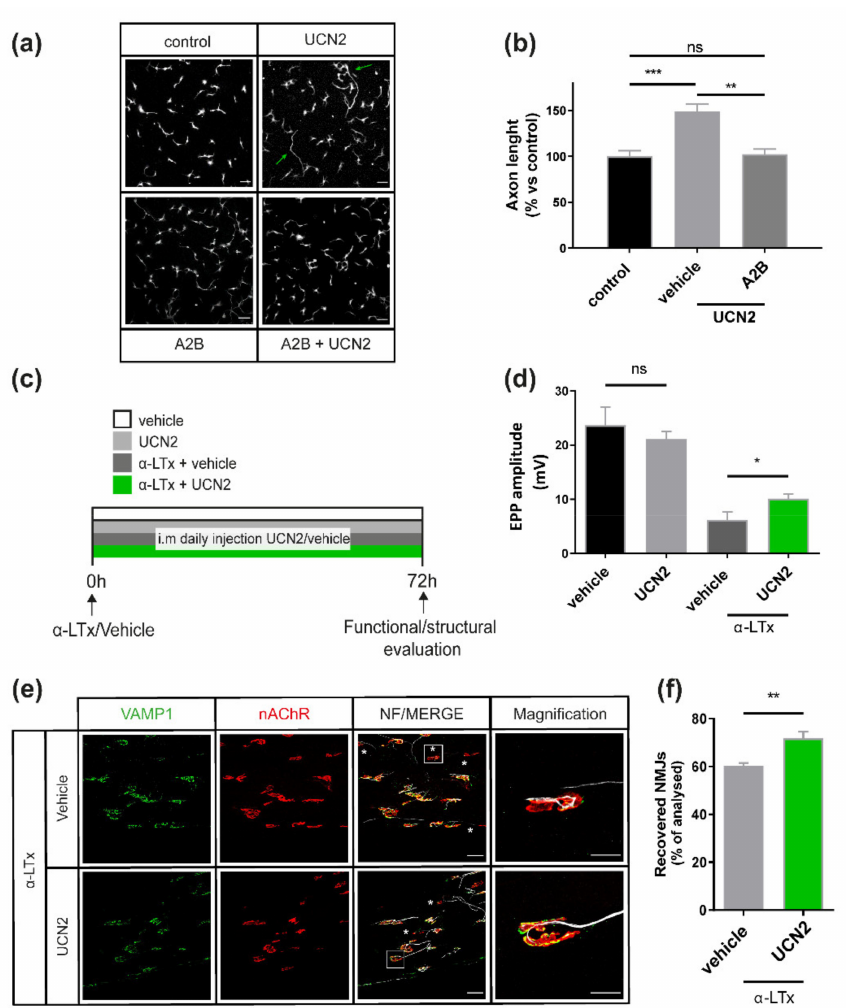
Figure 4. The UCN2-CRHR2 axis promotes axonal growth of cultured SCMNs and NMJ regeneration after acute damage. ( a ) Representative images of neurofilament staining used as reporter for axon length in SCMNs cultured for 24 h either in normal culture medium (NC) or NC supplemented with UCN2, A2B or their combination. ( b ) Quantification of the average axonal length after the indicated treatments. Three independent experiments were performed, and at least 100 neurons per condition measured. Bars represent mean ± SD. Statical analysis was performed with ANOVA followed by post hoc Tukey test; *** p < 0.001, ** p < 0.01, ns p > 0.05. ( c ) Scheme illustrating the treatment protocol, consisting of daily i.m. injections of either vehicle or recombinant UCN2 for 72 h after α -LTx treatment, followed by functional and structural assessment of NMJ status. ( d ) Electrophysiological assessment of NMJ function by evoked EPPs recordings following either vehicle or UCN2 administration. Each bar represents mean ± SD. n = 4 animals, 11 fibres. * p < 0.05, ns p > 0.05. ANOVA followed by post hoc Tukey test. ( e ) Representative immunostaining and ( f ) quantification performed on soleus muscles after intoxication and treatment with either vehicle or UCN2. Regenerated NMJs are positive for both pre- and post-synaptic markers (VAMP-1 in green and nAChR in red, respectively). White asterisks indicate still degenerated NMJs (absent or faint VAMP1 signal). Right panels are magnifications of the indicated NMJs. Scale bars: 50 µ m, 20 µ m for magnification. Each bar in ( f ) represents the mean ± SD percentage of recovered NMJs. ** p < 0.01 by Student’s t